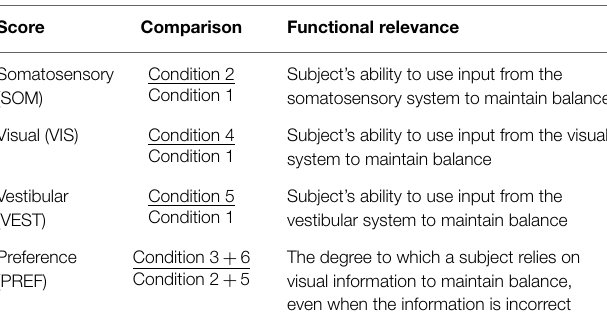
TABLE 3 | Sensory (visual, proprioceptive, and vestibular) scores calculated by the Equitest